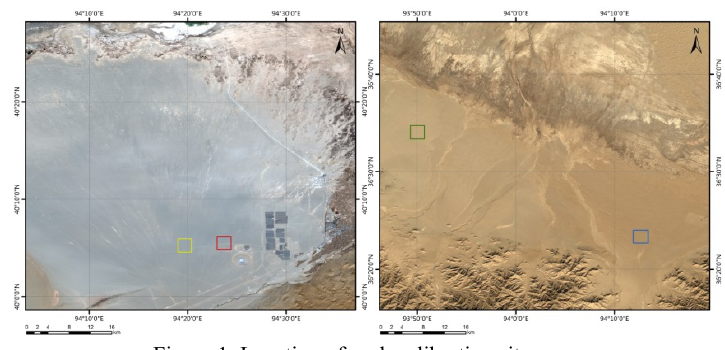
Figure 1. Location of each calibration